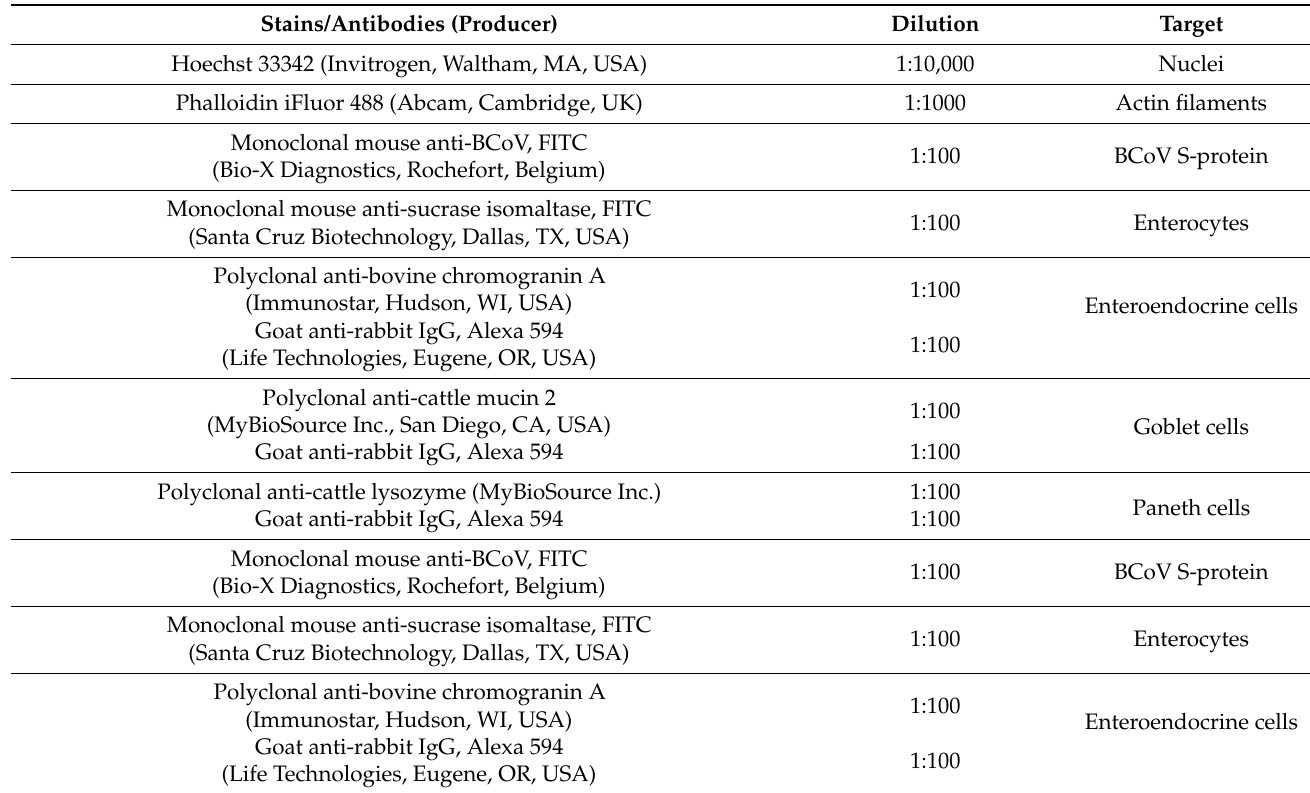
Table 1. Stains and antibodies used for cell nuclei and actin, BCoV envelope S-protein, and markers for cell